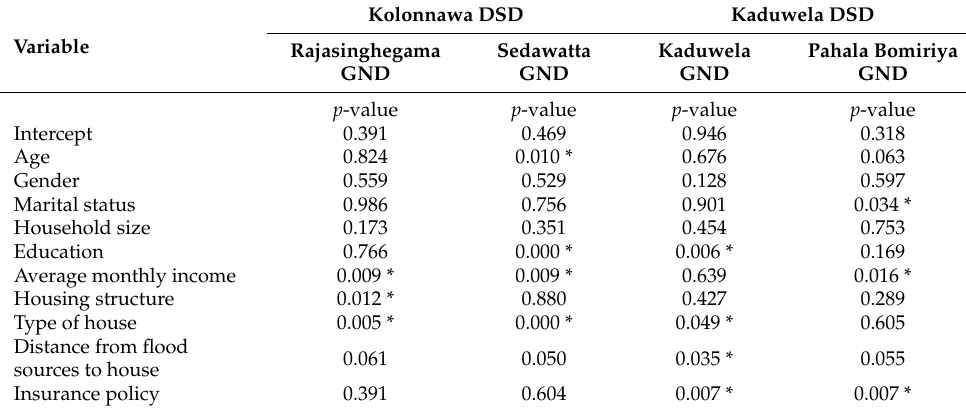
Table 2. Factors influenced respondents’ perceptions about flood